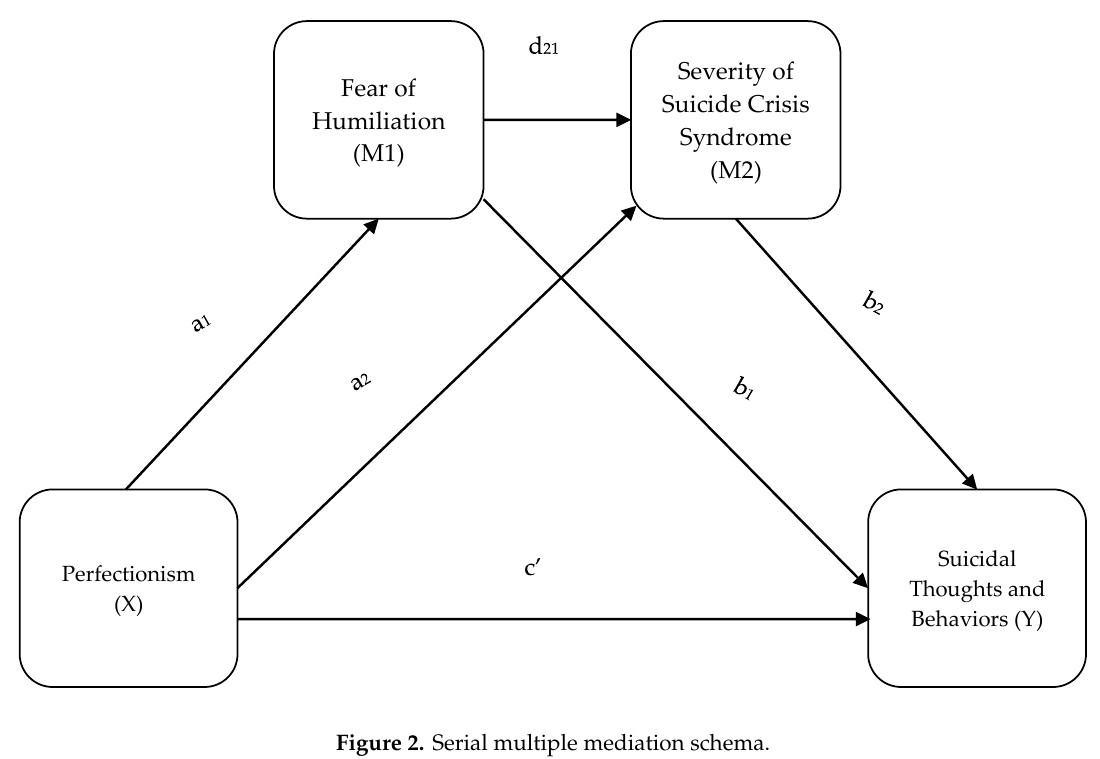
Figure 2. Serial multiple mediation